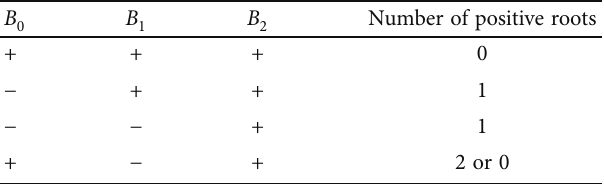
Table 1: Number of possible positive roots of system